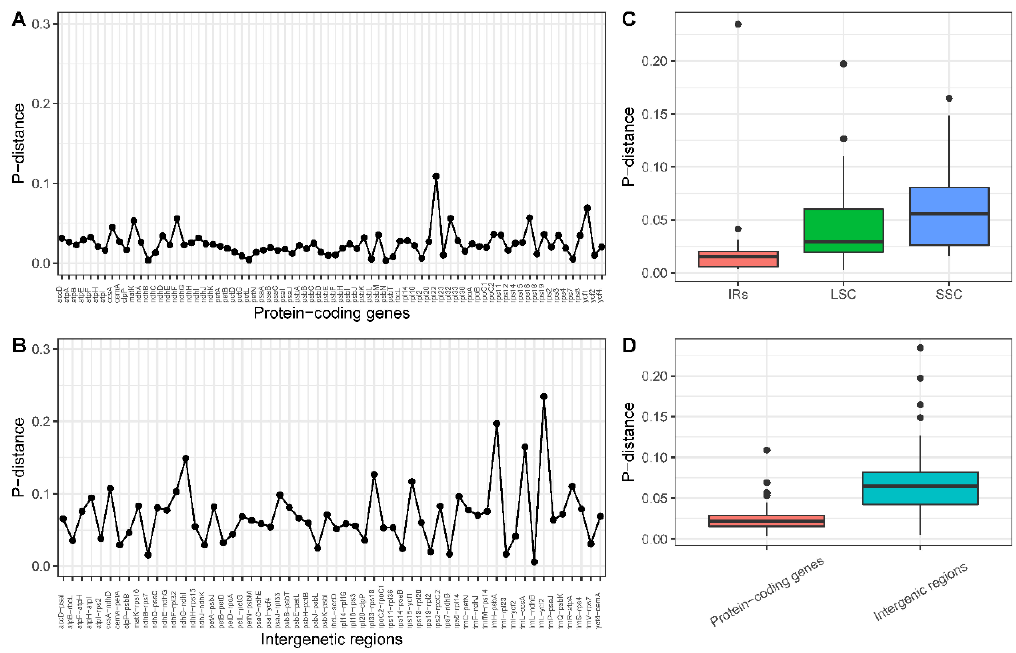
Figure 3. The genetic distance based on Kimura’s two-parameter model. ( A ) The P-distance value of protein-coding genes. ( B ) The P-distance value of intergenic regions. ( C ) Boxplots of P-distance value difference among LSC, SSC, and IRs. ( D ) Boxplots of P-distance value differences between protein-coding genes and intergenic regions.